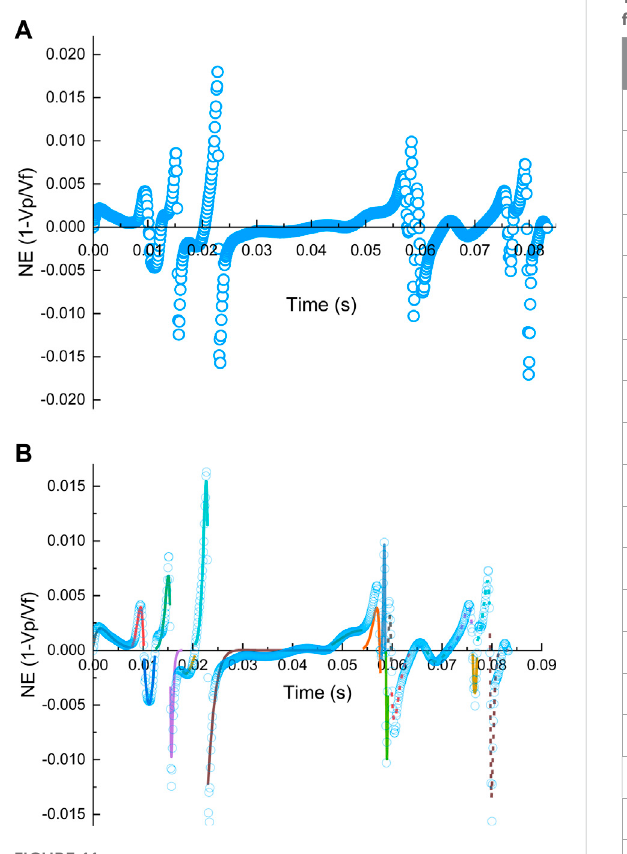
FIGURE 11 (A) NE as a function of time for a single particle injection in the pore structure. (B) Fitted NE curves for 20 stages. Each color represents one stage. Blue circles are the original